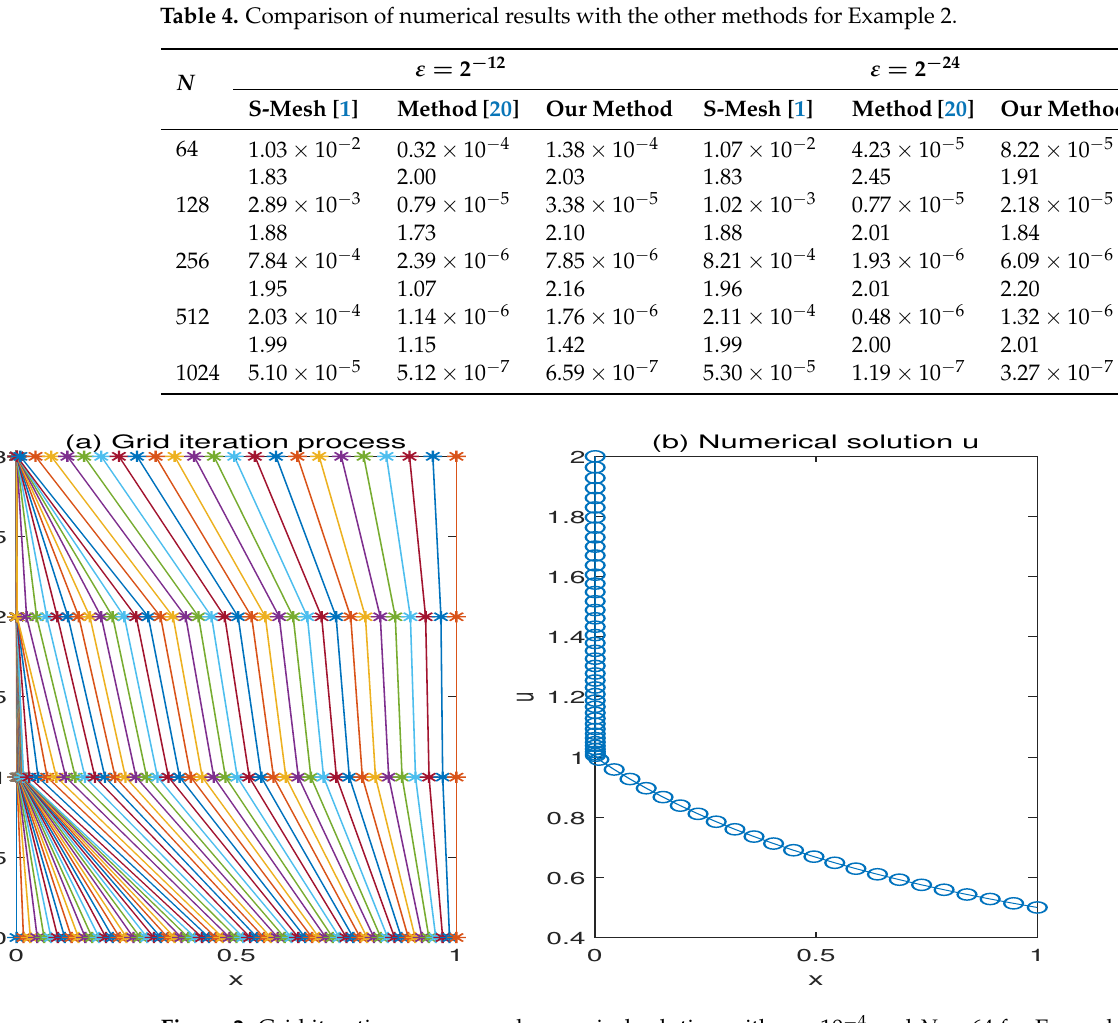
Figure 2. Grid iteration process and numerical solution with ε = 10 − 4 and N = 64 for Example 2. ( a ) Grid iteration process, ( b ) Numerical solution